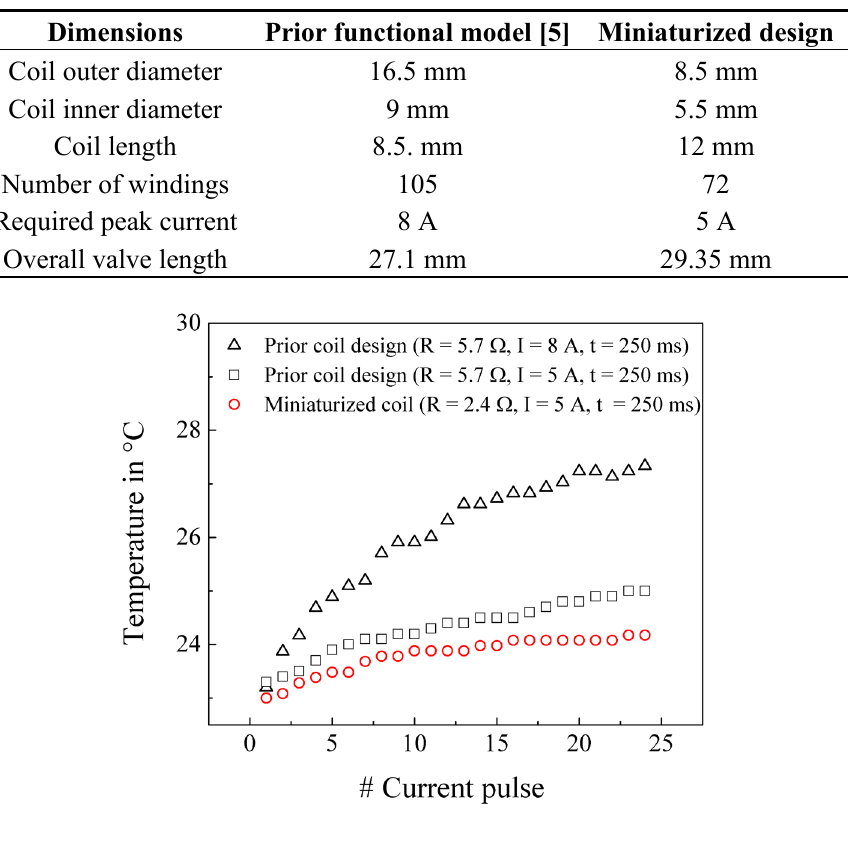
Figure 4. Comparison of the induced heat in the prior and the miniaturized coil